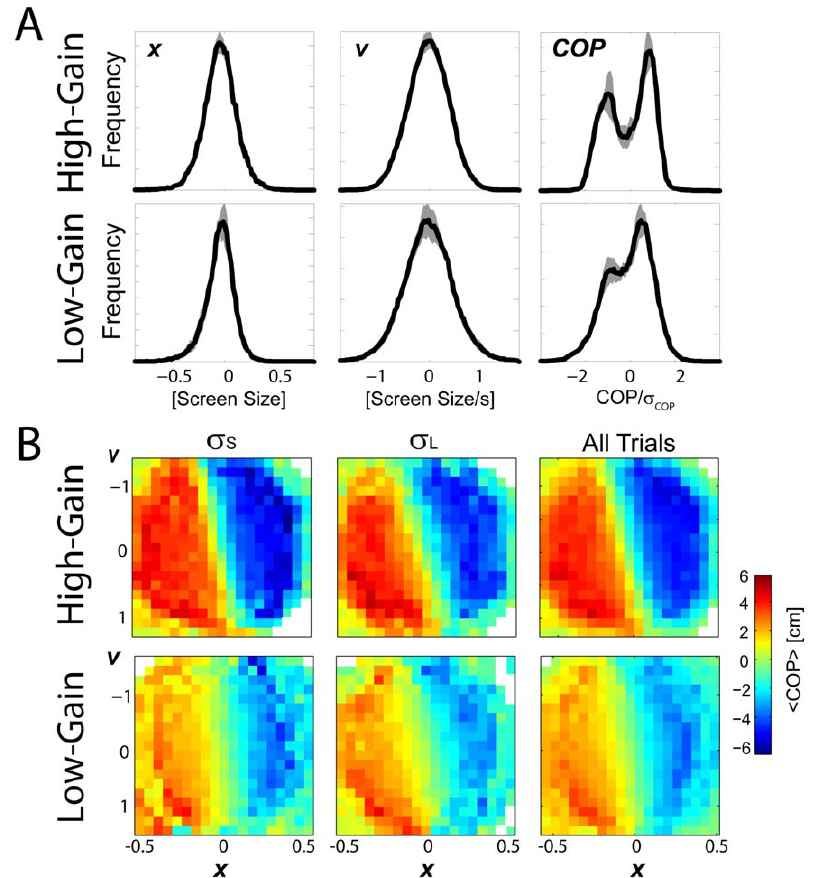
Figure 4. Control policies. A) Distributions of the cursor position (left), cursor velocity (center) and center of pressure normalized by the standard deviation (right), averaged across subjects for the low-gain (top row) and high-gain (bottom row) conditions. In the low-gain condition, note the bimodal distribution of the center of pressure, despite the unimodal distribution of errors. This may indicate a bang-bang-like strategy. B) Policy-maps of the center of pressure averaged across subjects as a function of the true cursor position and velocity for two different levels of feedback uncertainty and across all conditions. Note that in the low-gain condition subject’s responses saturate at large cursor velocities and positions. In the high-gain condition responses are much more